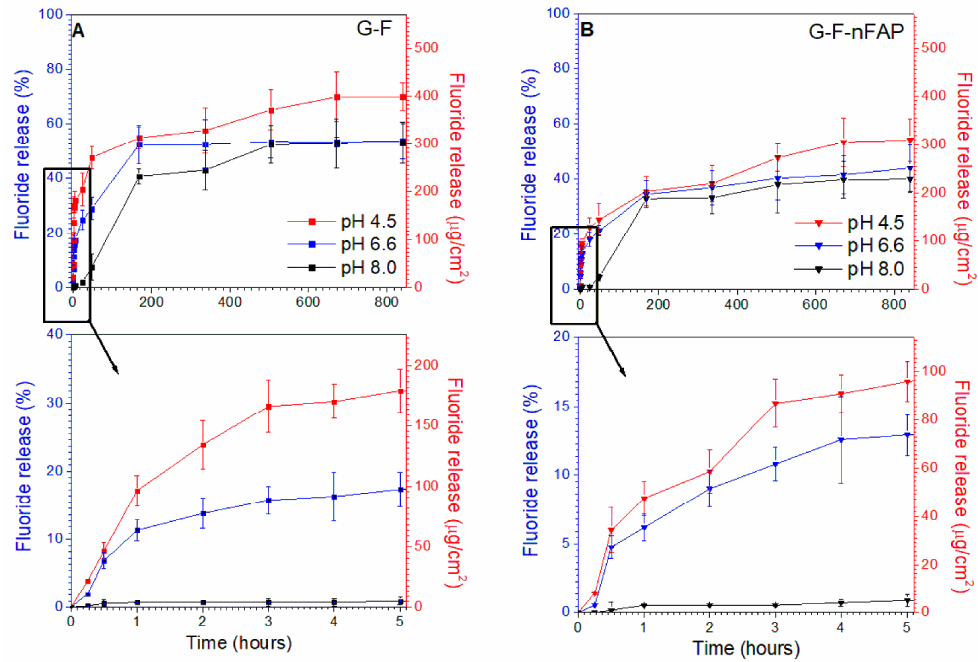
Figure 6. The fluoride release test in the artificial saliva for gel G-F ( A ) and gel G-F -nFAP ( B ) at different pH values (4.5, 6.6, and 8.0) and a temperature of 37 °C.